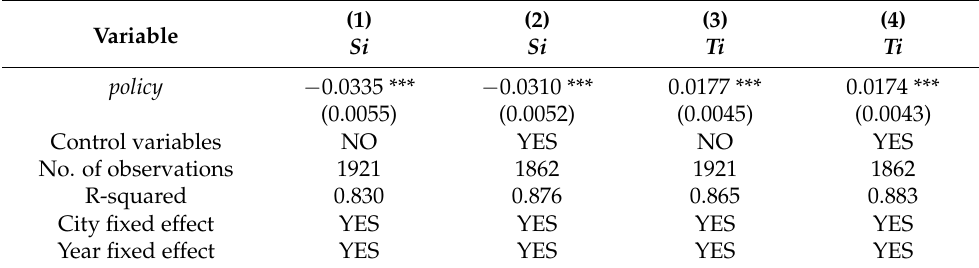
Table 7. Mechanism analysis—industry